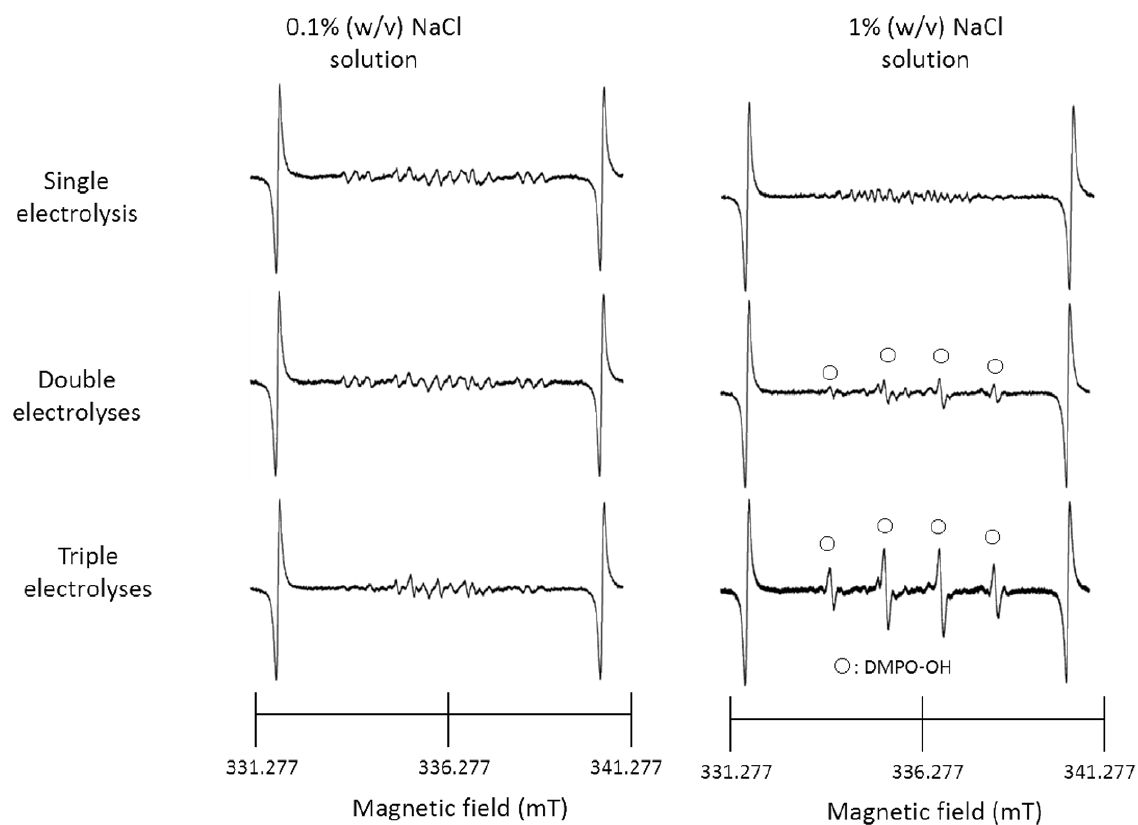
Figure 1. ESR spectra of AEW from single and repeated electrolyses of 0.1% and 1% (w/v) NaCl solutions.